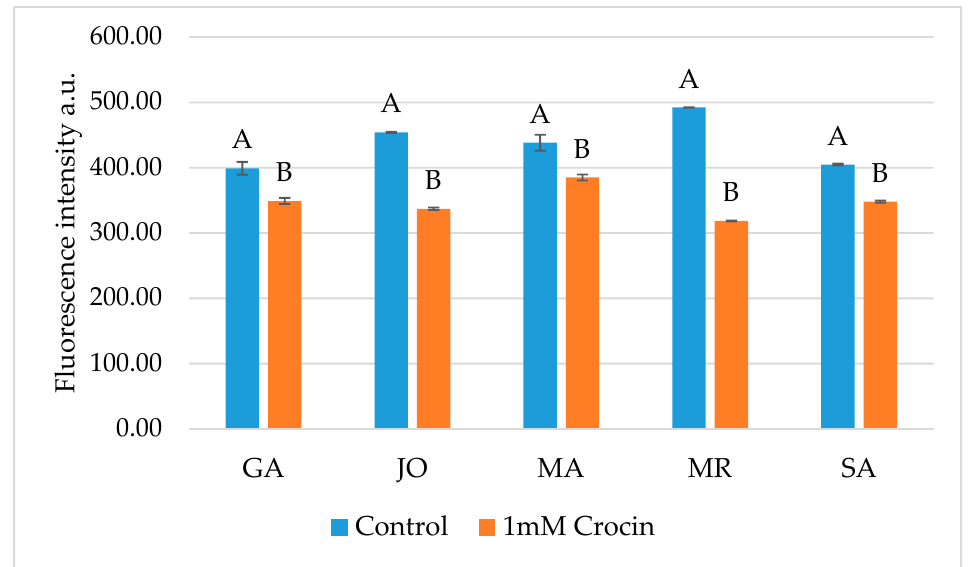
Figure 2. DHE fluorescence intensity of frozen–thawed goat sperm in different breeds: Garganica (GA), Jonica (JO), Maltese (MA), Mediterranean Red (MR) and Saanen (SA) between 0 mM (control) and 1 mM crocin groups. A,B Bars with different letters are significantly different; p < 0.01.